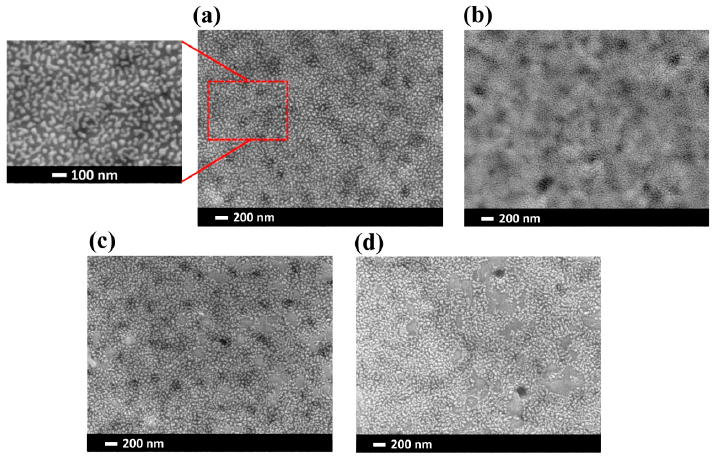
Figure 4. The scanning electron microscope (SEM) images of PCBM ETLs based on the ( a ) DCB, ( b ) CB, ( c ) MB, and ( d ) CF solvents.